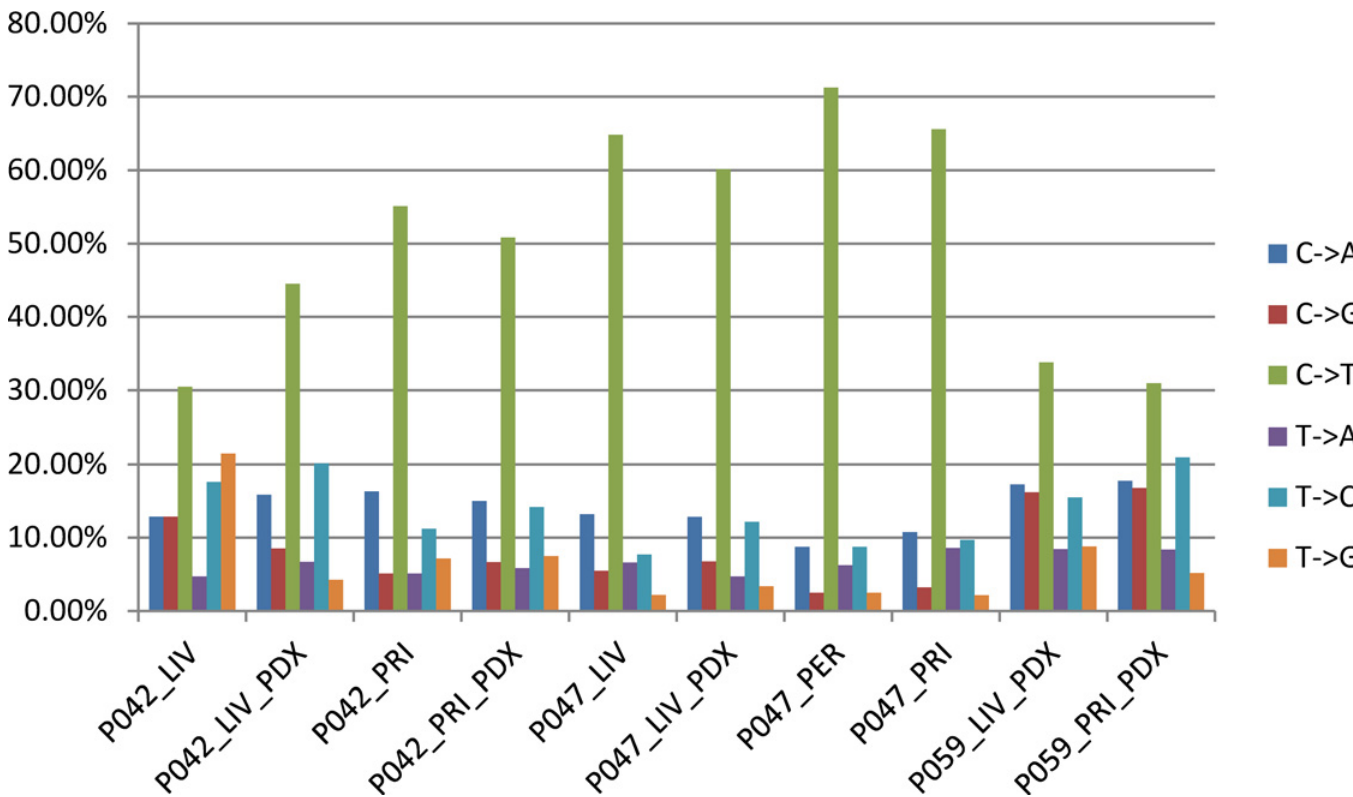
Fig 1. Somatic mutation patterns of primary, metastatic and PDX tumors. Proportion of somatic SNVs by class (C- > A, C- > G, C- > T, T- > A, T- > C and T-G) in the primary, metastatic and PDX tumor samples are shown for the ten cancer samples included in this